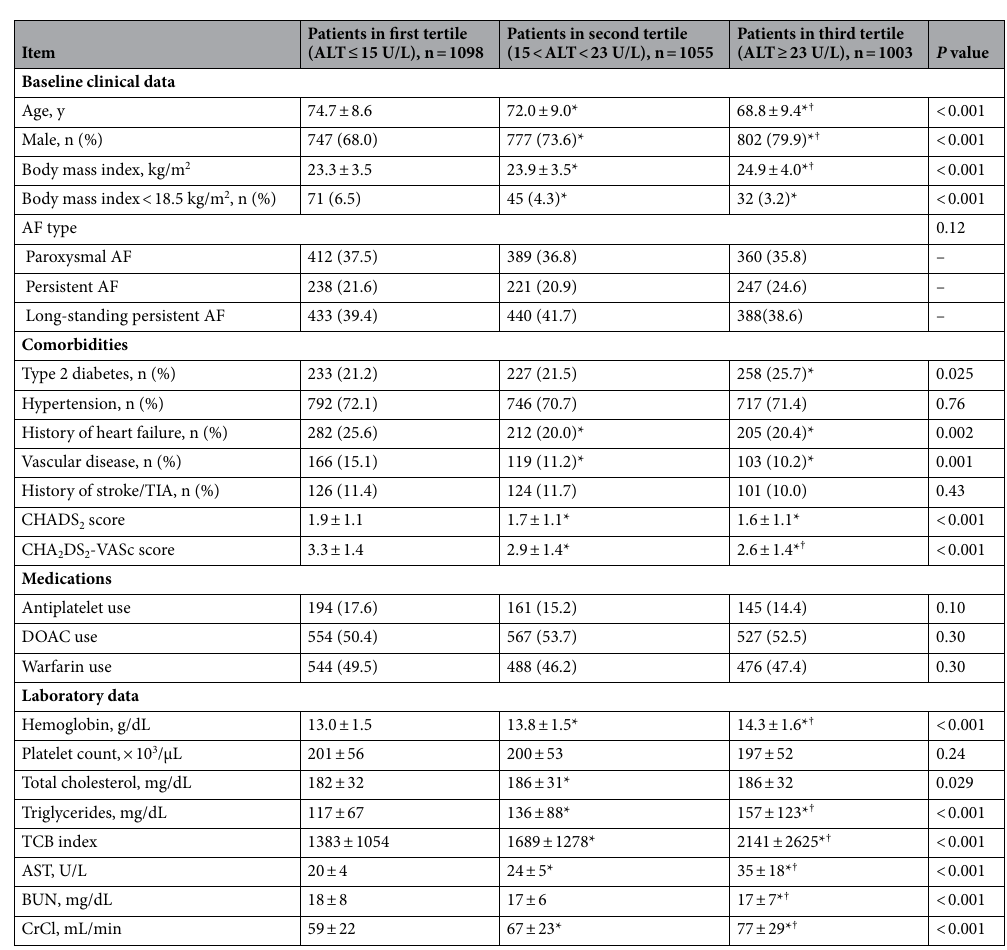
Table 1. Baseline patient characteristics according to baseline alanine aminotransferase level. Values are shown as mean ± SD or number (%), unless otherwise indicated. For multiple comparisons, analysis of variance was used for symmetric continuous variables, the Kruskal–Wallis test was used for asymmetric continuous variables, and the Chi-squared test was used for categorical variables. All pairwise comparisons were performed with the Tukey–Kramer test for symmetric continuous variables, the Steel–Dwass test for asymmetric continuous variables, and the Chi-squared test with Bonferroni correction